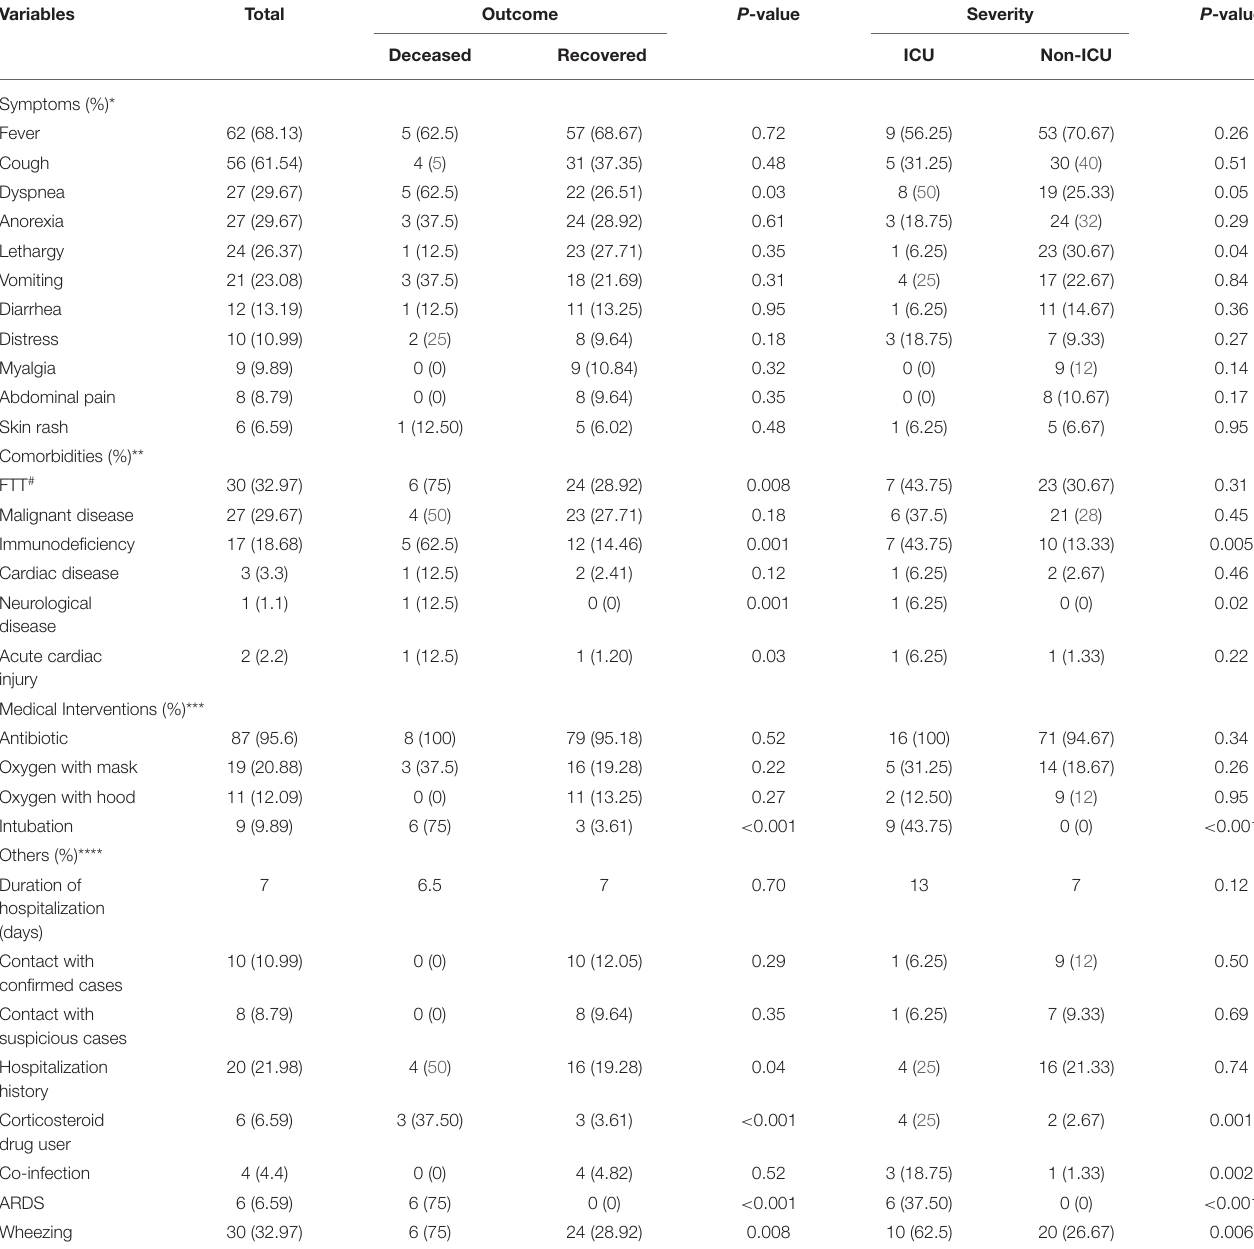
TABLE 2 | Clinical data of pediatric COVID-19